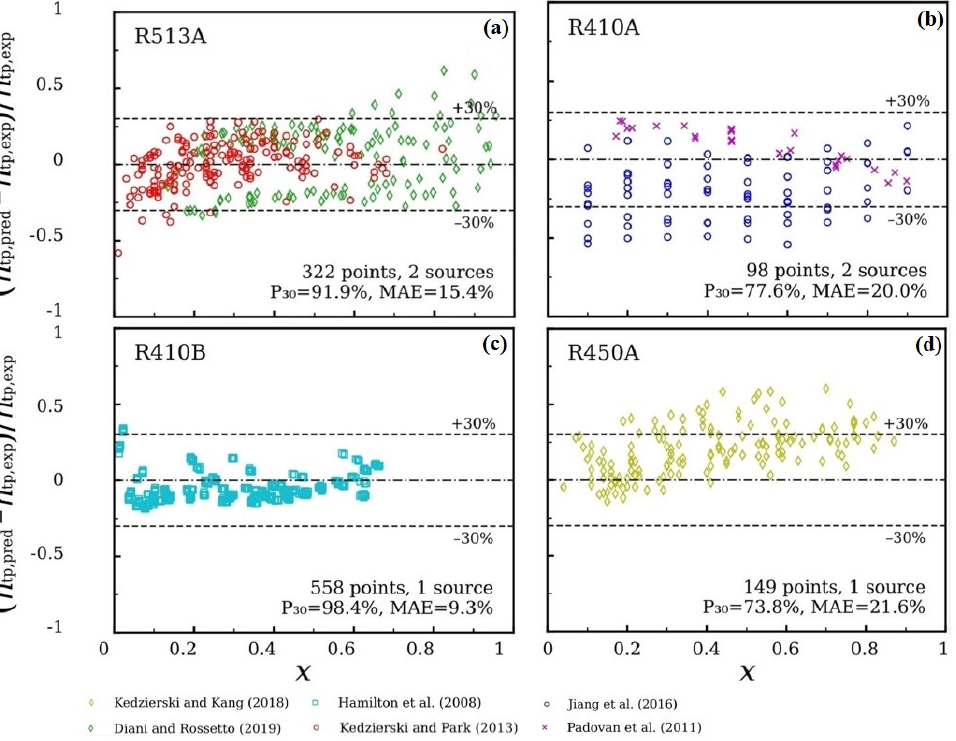
Figure 13. Comparison of different models on the basis of relative residuals to Lin et al. [120] model versus vapor quality for refrigerants ( a ) R513A, ( b ) R410A, ( c ) R410B, and ( d ) R450A.